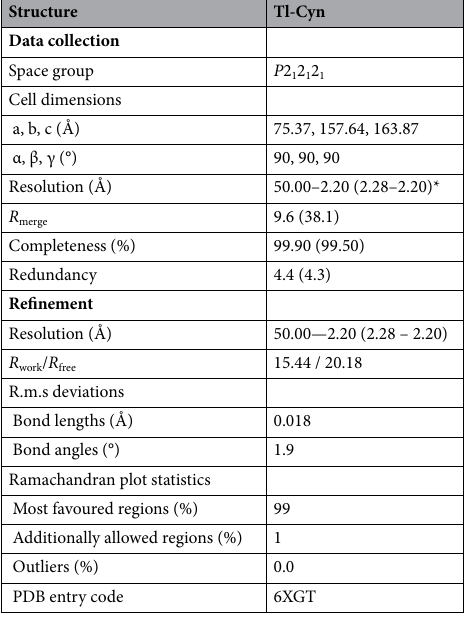
Table 1. Crystallographic data collection and refinement statistics. *Highest resolution shell is shown in